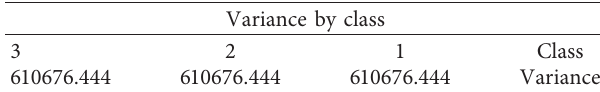
Table 6: The variance by the three components.